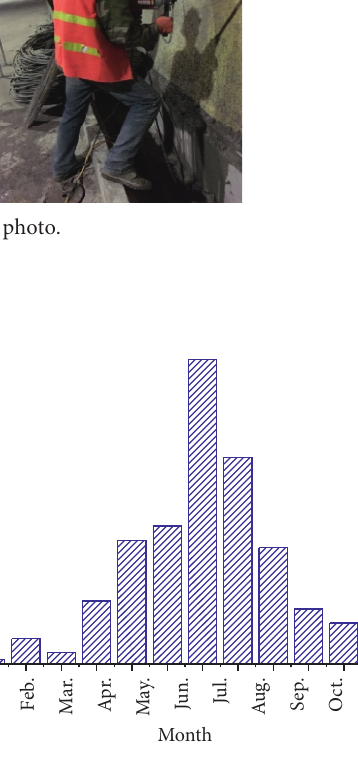
Figure 3: Temperature of Dugongling tunnel site. Figure 4: Rainfall of Dugongling tunnel